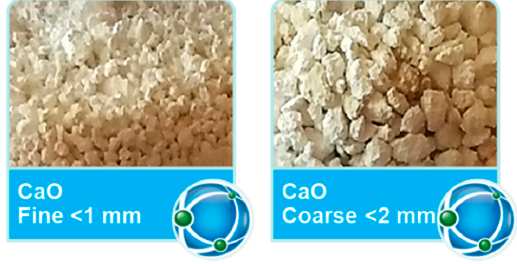
Table 4. Properties of fine and coarse burnt lime.